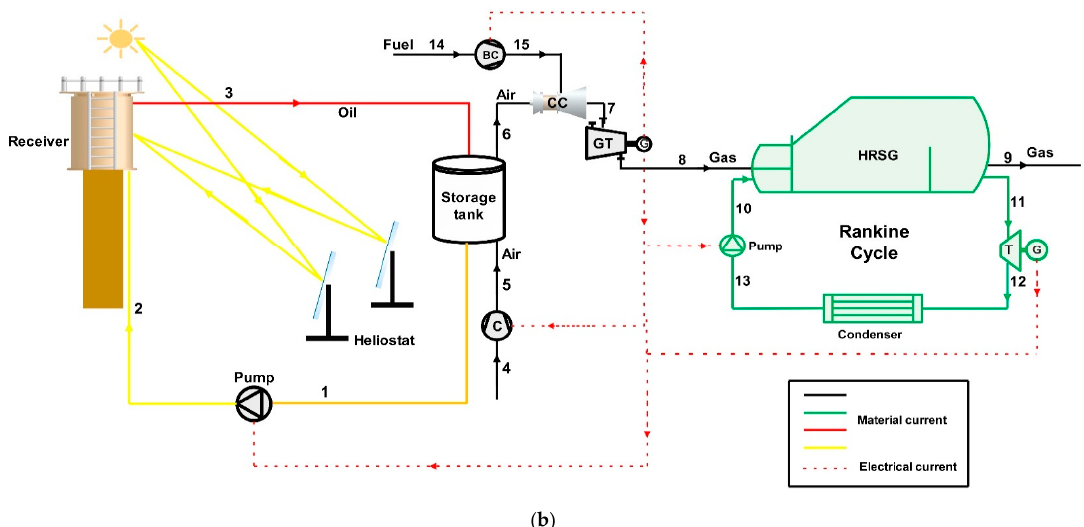
Figure 1. Layout diagram of the combined: ( a ) gas turbine (GT)-heat recovery steam generator (HRSG) and ( b ) GT-HRSG-heliostat solar receiver (HSR).